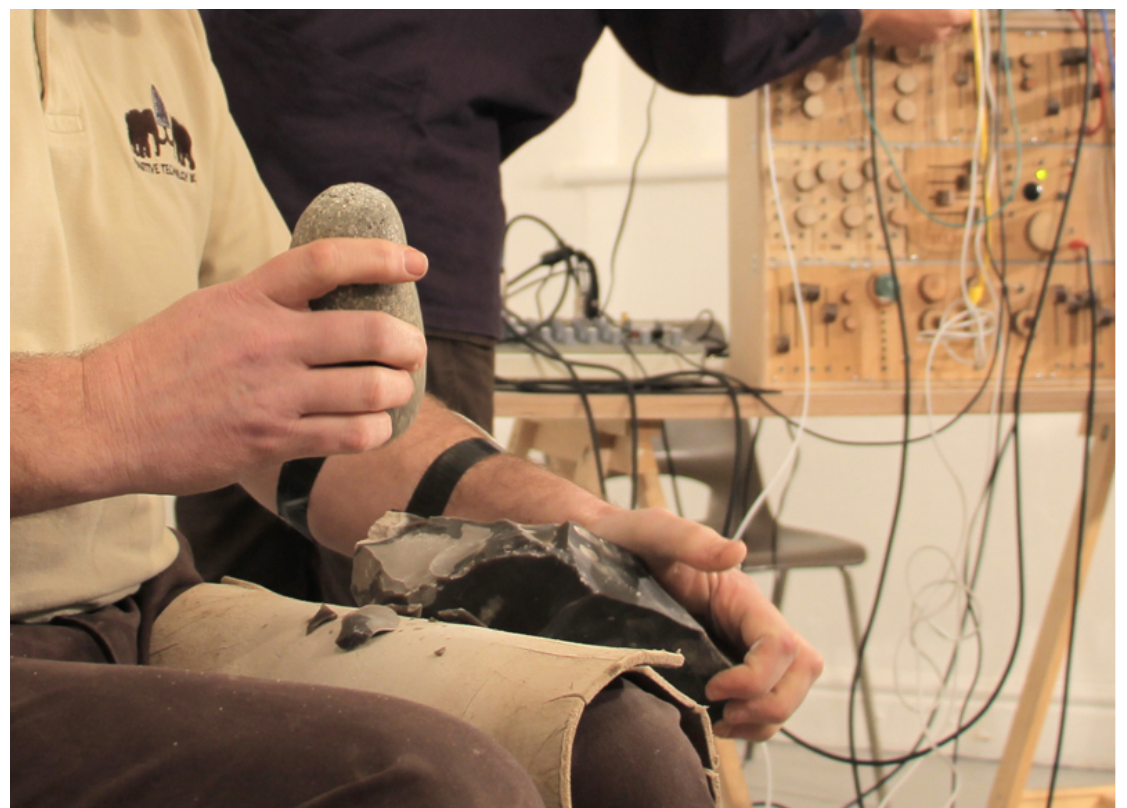
Figure 1. Stone Music: Recording a hand axe. The sensors are strategically placed to record the sound and rhythm of the knapper; a. roughing out the hand axe using a stone hammer (Photograph courtesy of the Owl project and Simon Blackmore.)